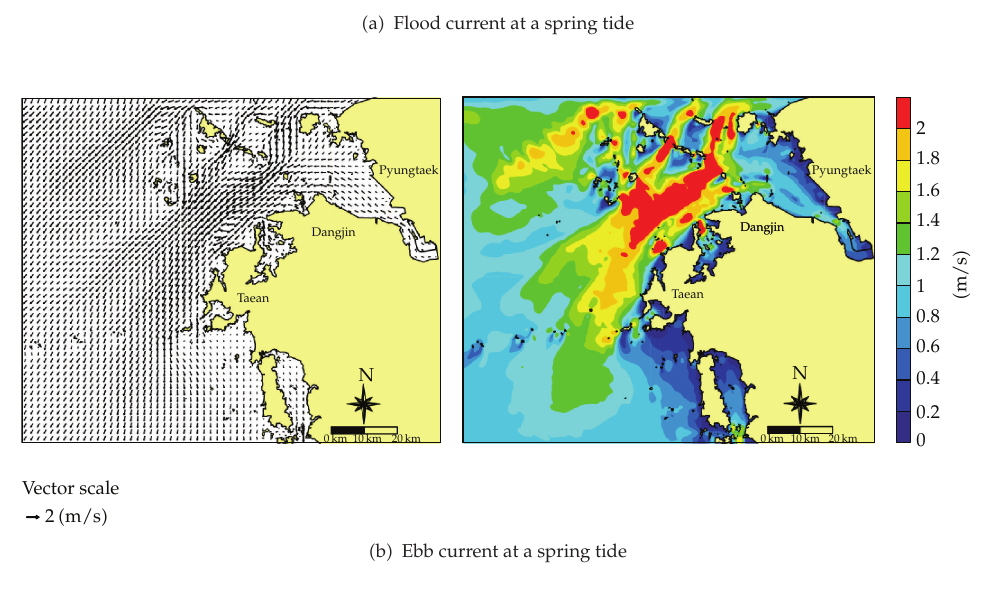
Figure 8: Distribution of tidal currents near the target